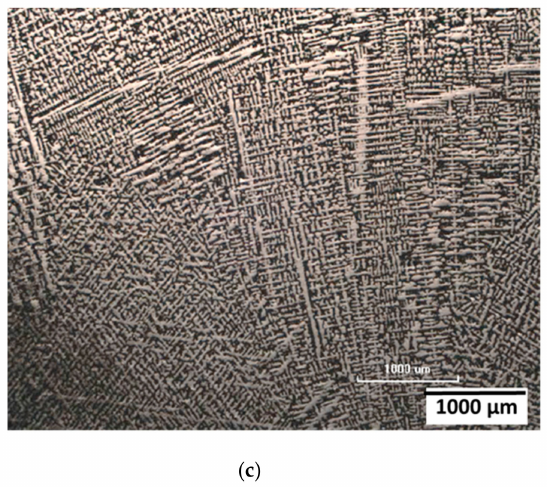
Figure 14. Microstructure of ( a ) SLM as-built, ( b ) wrought, and ( c ) cast, Alloy